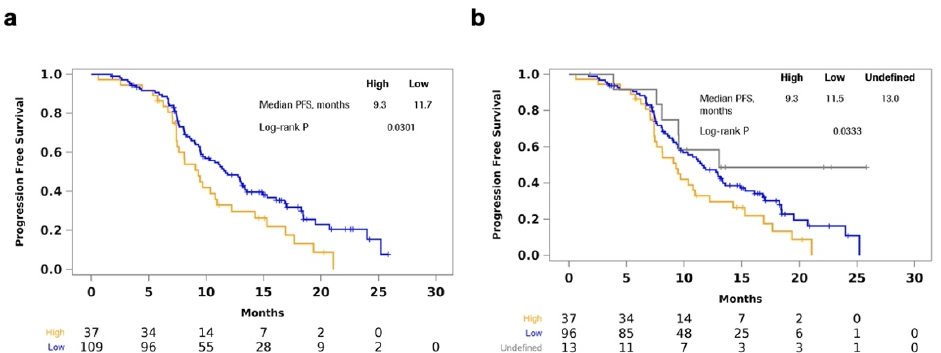
Figure 2. Shorter PFS in high pre-induction MATH. ( a ) Kaplan–Meier curves showing shorter PFS with high tumor heterogeneity, defined as MATH in the top quartile in pre-induction plasma; ( b ) longer PFS with MATH below the top quartile or undefined, i.e., samples with 0 or 1 somatic mutations detected.